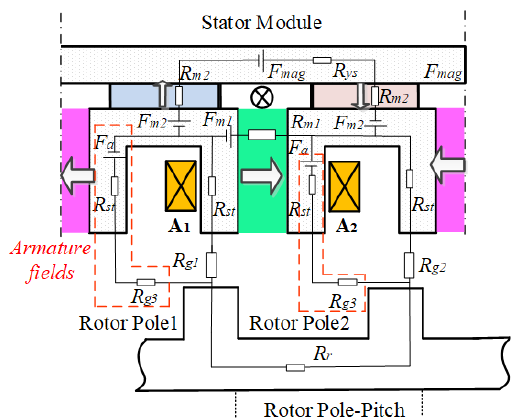
circuit model, when the rotor aligns with the d -axis, is established as shown in Figure 7. F mag is the magnetizing MMF.